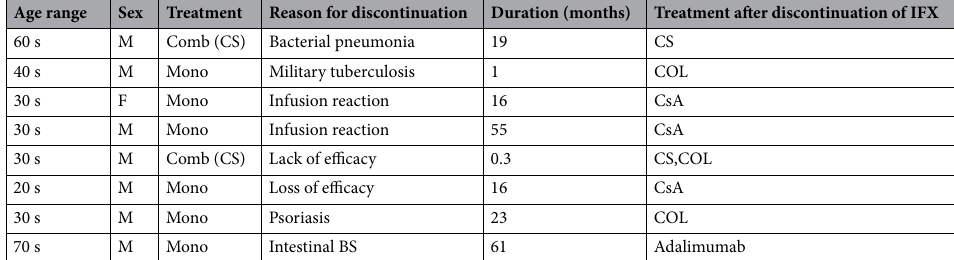
Table 5. Details of IFX discontinuation. BD: Behçet’s syndrome, Mono: monotherapy, Comb: combination therapy, IFX: infliximab, CS: corticosteroid, COL: colchicine, CsA: cyclosporin A.